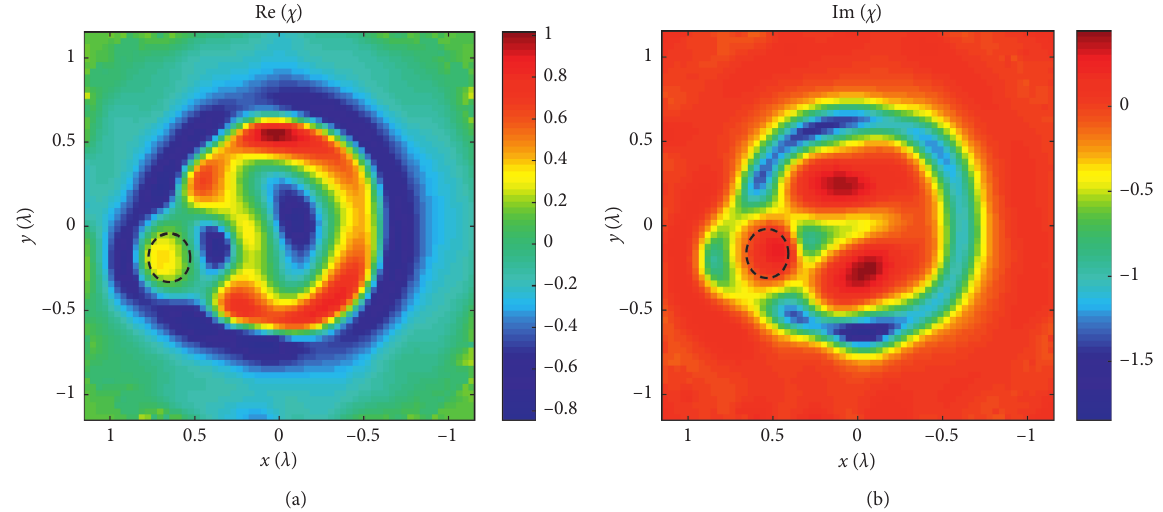
Figure 6: Real (a) and imaginary (b) part of the contrast function χ for the first scenario.